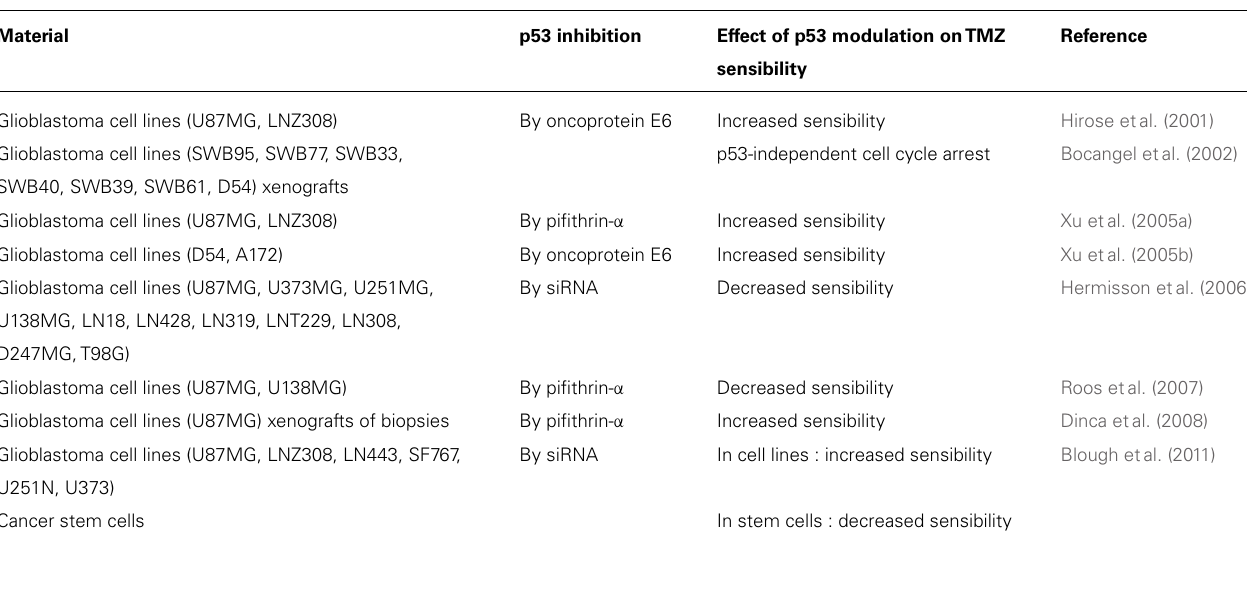
Table 2 | Role of p53 inTMZ